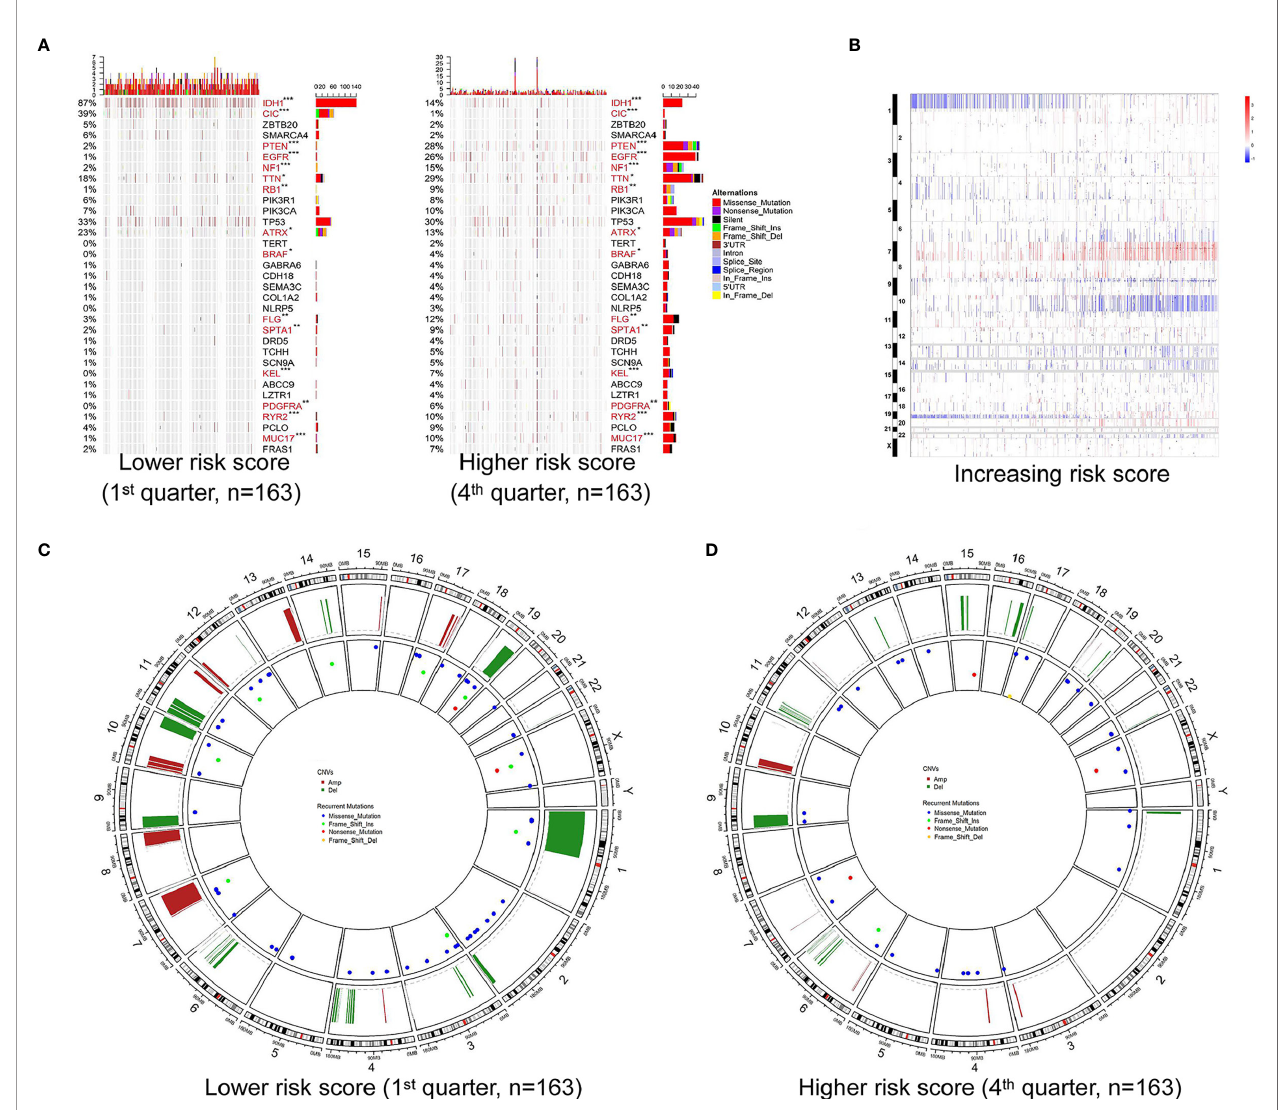
FIGURE 3 | Different mutation and copy number variation pattern of the risk score. (A) Summary of well-known individual regulators of glioma from the lower and higher risk score samples from the TCGA RNA-seq cohort. Columns are sorted by samples with increasing risk score. Top histogram, sum of mutations in each sample category indicated by the legend; Right histogram, sum of mutations in each gene indicated by the legend. (B) The overall copy number variation (CNV) pro fi le in order of increasing risk score in the TCGA RNA-seq cohort. (C, D) A distinct recurrent CNV and mutation pro fi le is observed between gliomas with a lower and higher risk score in the TCGA RNA-seq cohort. *P < 0.05; **P < 0.01; ***P <